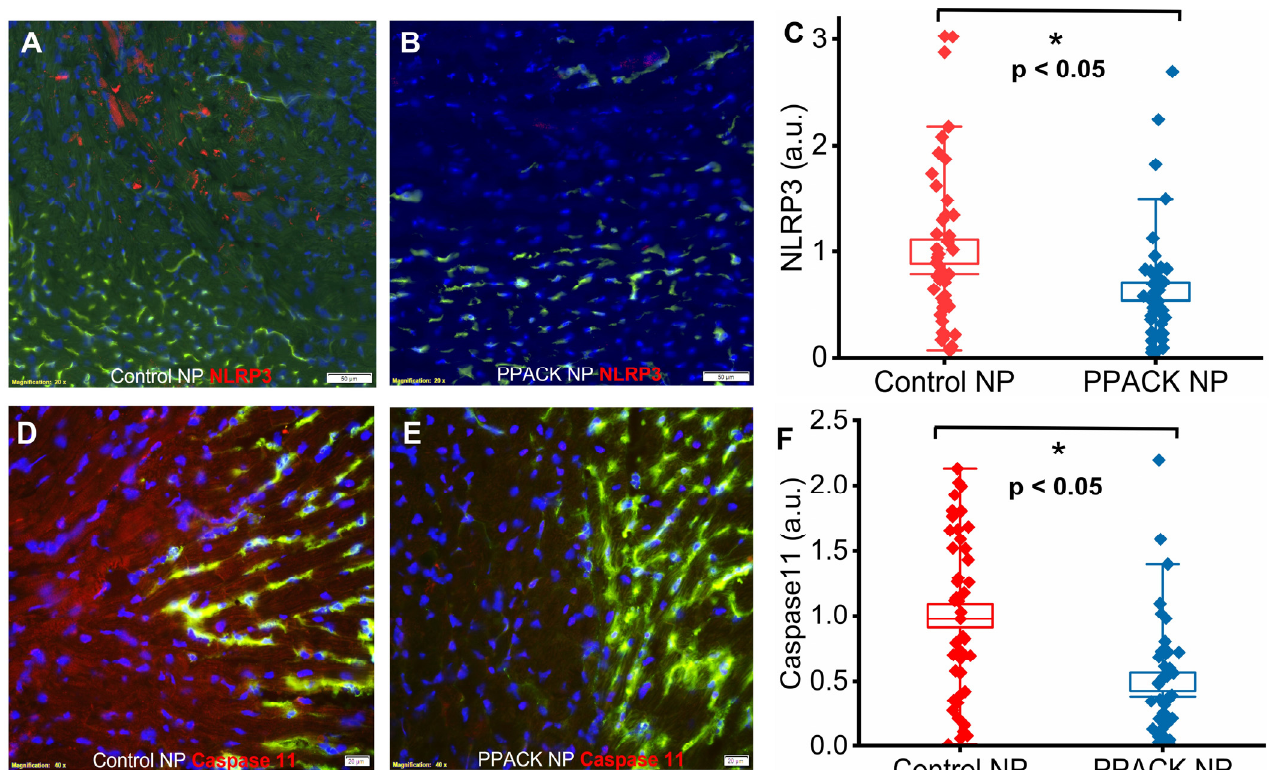
Figure 6. PPACK PFC NP treatment reduces inflammasome activation. ( A ) Immunofluorescent image of NLRP3 (red) staining in control NP-treated hearts. ( B ) Immunofluorescent image of NLRP3 (red) staining in PPACK NP treated hearts. Green fluorescence signal indicates blood vessels in the normal region of the heat. DAPI was used for nuclei staining (blue). The size of the scale bar was 50 µm, and the magnification was 20×. ( C ) Quantification of NLRP3 in border zones from control NP or PPACK NP treated hearts ( n = 3 mice per group; n = 42 PPACK NP, and n = 45 control NP regions of interest. Mean ± SEM; nonparametric analysis on n = 3). ( D ) Immunofluorescent image of caspase 11 (red) staining in control NP-treated hearts. ( E ) Immunofluorescent image of caspase-11 (red) staining in PPACK NP treated hearts. Green fluorescence signal indicates blood vessels in the normal region of the heat. DAPI was used for nuclei staining (blue). The size of the scale bar was 20 µm, and the magnification was 40×. ( F ) Quantification of caspase-11 in border zones from control NP or PPACK NP treated hearts ( n = 3 mice per group; n = 45 PPACK NP, and n = 45 control NP regions of interest. Mean ± SEM; nonparametric analysis on n = 3; *: p < 0.05).